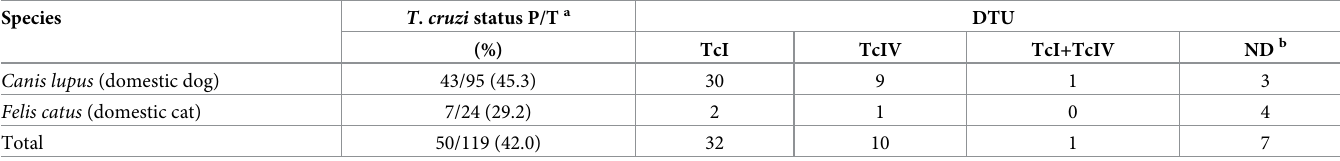
Table 3. Prevalence of T . cruzi infections and DTU genotyping in feral or stray dogs and cats collected in El Paso County, TX. Species